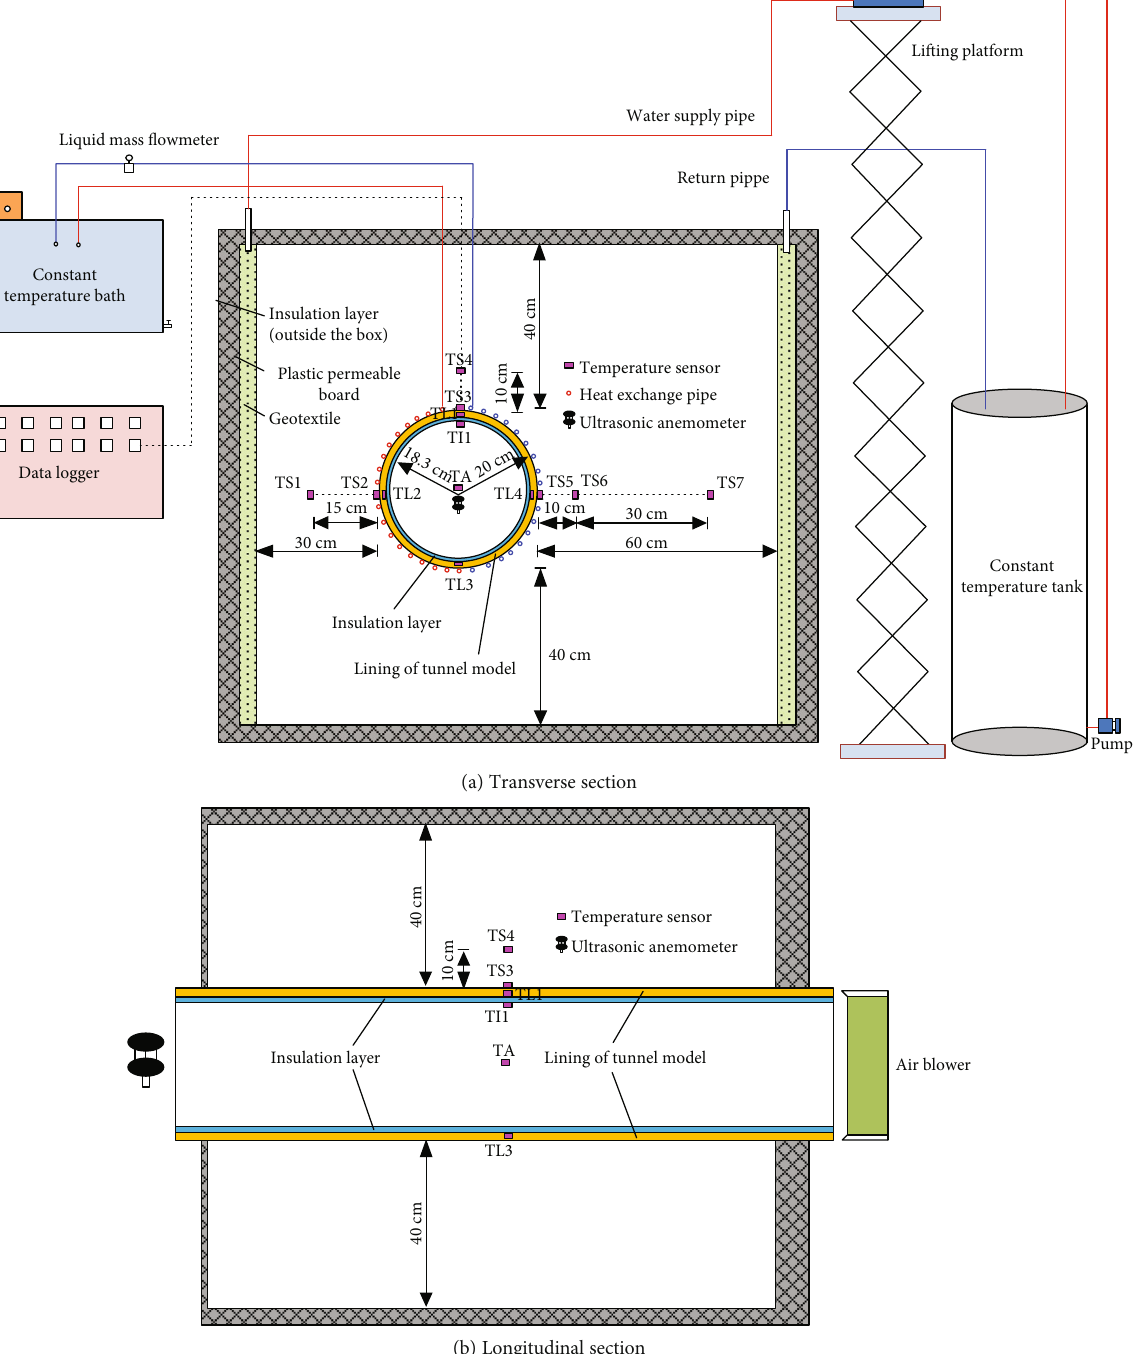
Figure 1: Schematic diagram of the tunnel model test